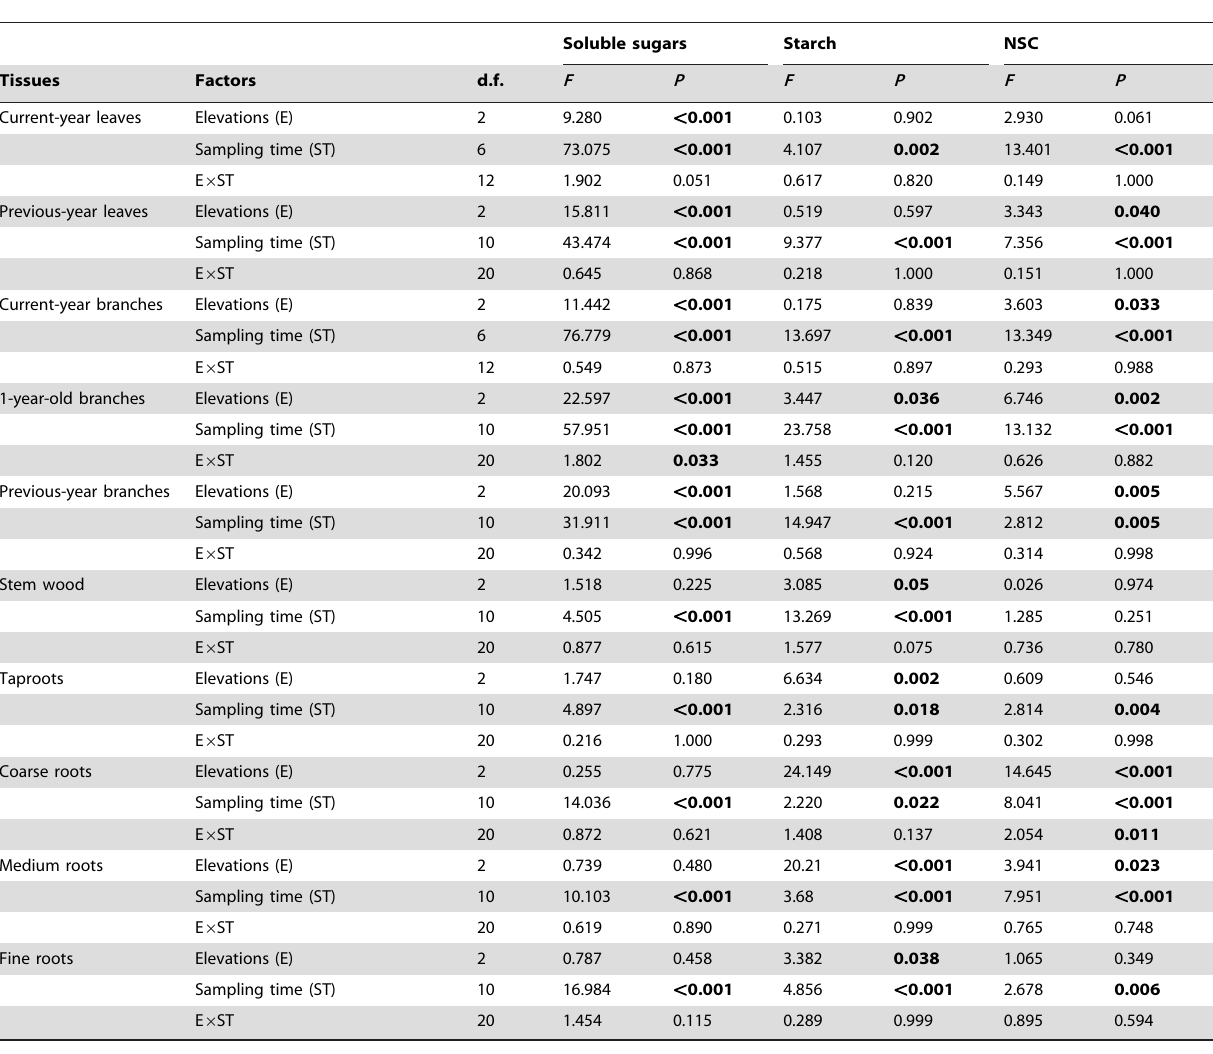
Table 2. Analysis of variance of the effects of elevations (3000 m, 3500 m and 3950 m a.s.l.) and sampling time (from April 2008 to October 2009) on concentrations of nonstructural carbohydrate (NSC) and its components (sugars, starch) in different tissues of Quercus aquifolioides